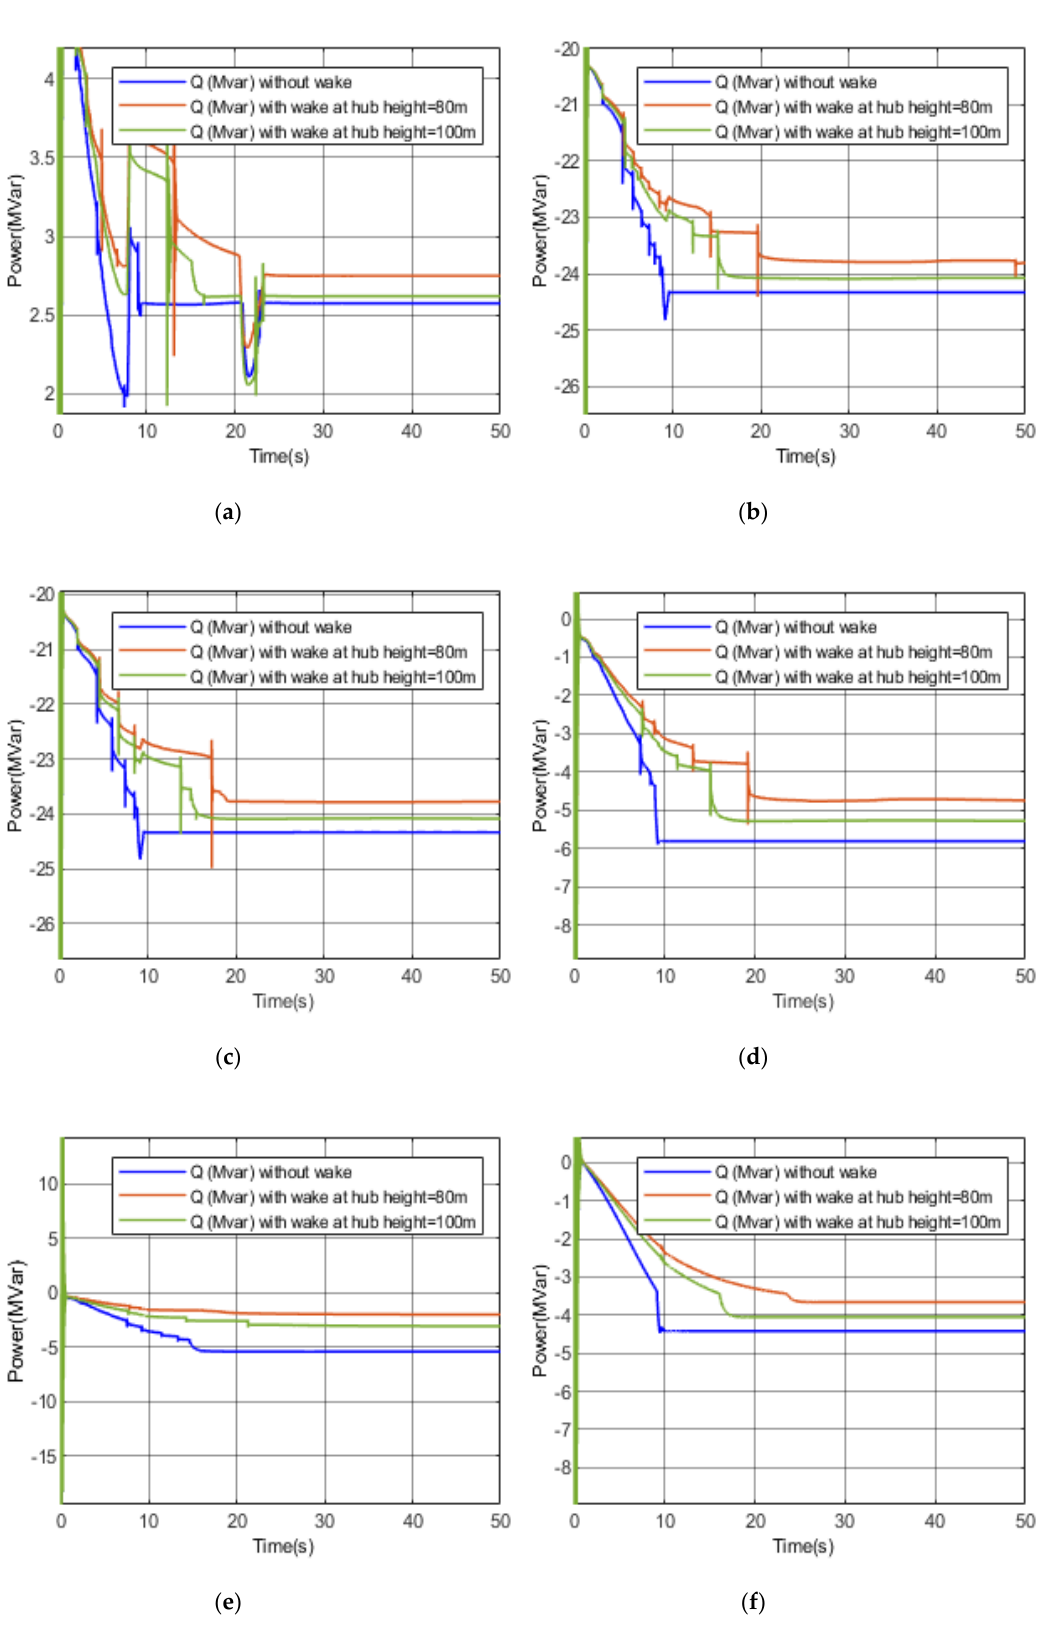
Figure 15. Special case Q profiles: ( a ) Q in Ideal case; ( b ) Q with capacitor bank; ( c ) Q with SVC; ( d ) Q with STATCOM; € Q with SSSC; and ( f ) Q with